Question: Give a one-sentence summary of this figure.
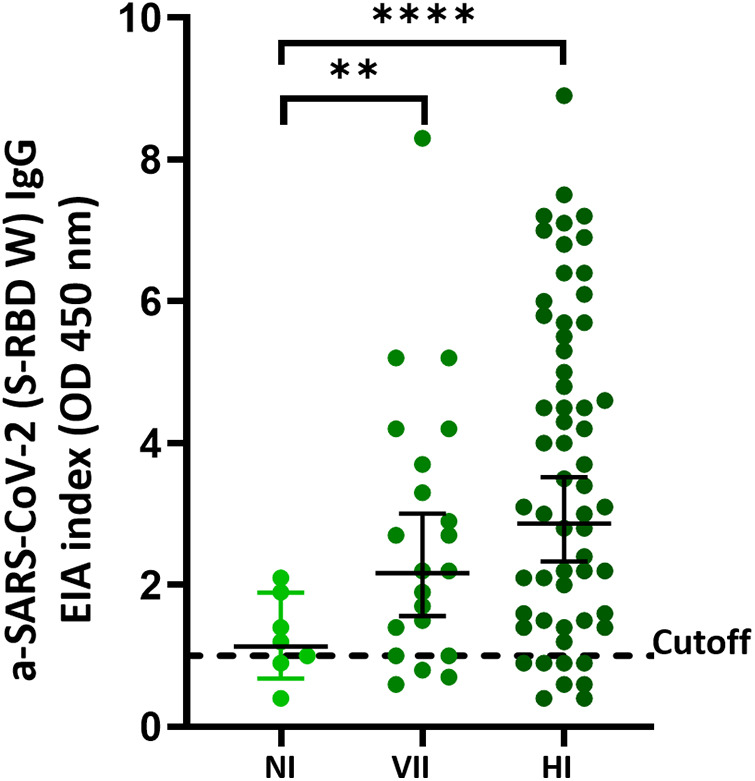
Answer: Geometric mean comparison of anti-RBD Index IgG EIA levels in newborns from mothers with different immunization statuses. NI, Natural Immunity; VII, vaccination-induced immunity; HI, Hybrid Immunization, (**) Indicates a significance level of P < 0.0002, (****) Indicates a significance level of P < 0.0001. Welch's ANOVA means comparison test. Prepared in Graph Pad Prism 8.